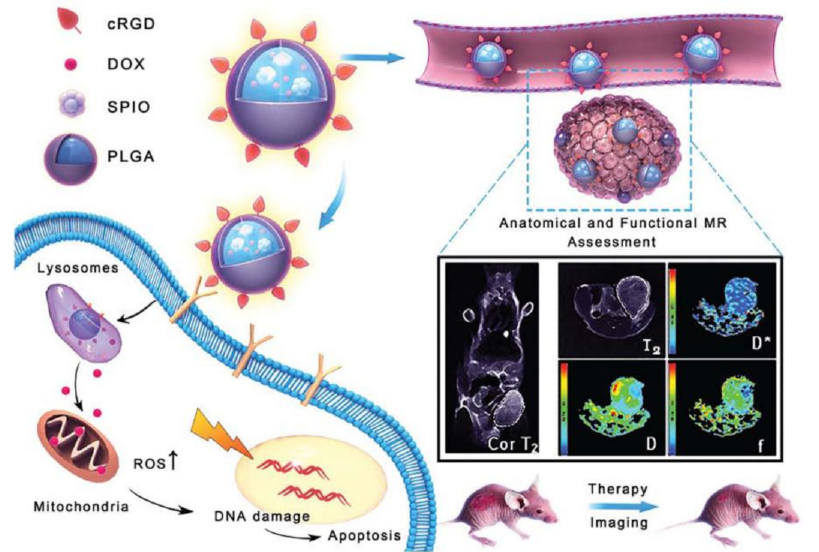
Figure 9. Schematic representation of the cRGD–PLGA–SPIO@DOX multifunctional NPs for tar- geted tumor therapy and MR imaging. The SPIO and DOX were encapsulated by cRGD peptide- functionalized poly(lactic-coglycolic acid) (cRGD–PLGA) block copolymer. The as-synthesized nanosystem (cRGD–PLGA–SPIO@DOX) exhibited excellent pH-responsive drug release properties under physiological conditions and integrin-targeting ability, which can act as a theranostic agent for MRI-guided cancer therapy (Adapted from Xiao et al. 2019 [229], Copyright 2019 The Royal Society of Chemistry and reproduced with